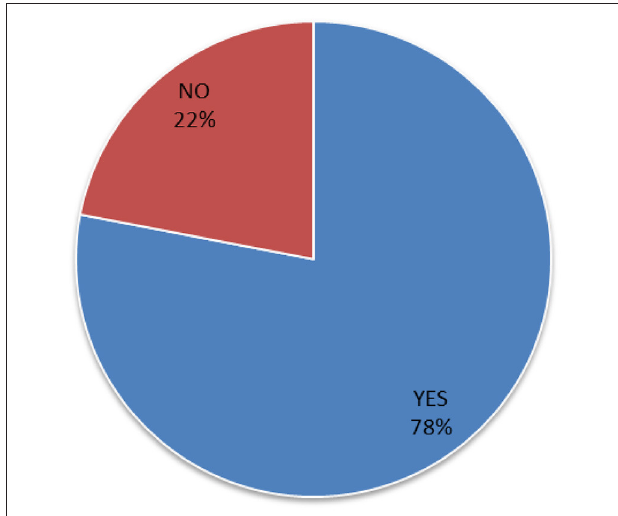
FIGURE 2 | Types of social media used to find information about a healthy diet ( n = 308, M = 4.11, SD = 1.534, CI = 3.97–4.24).